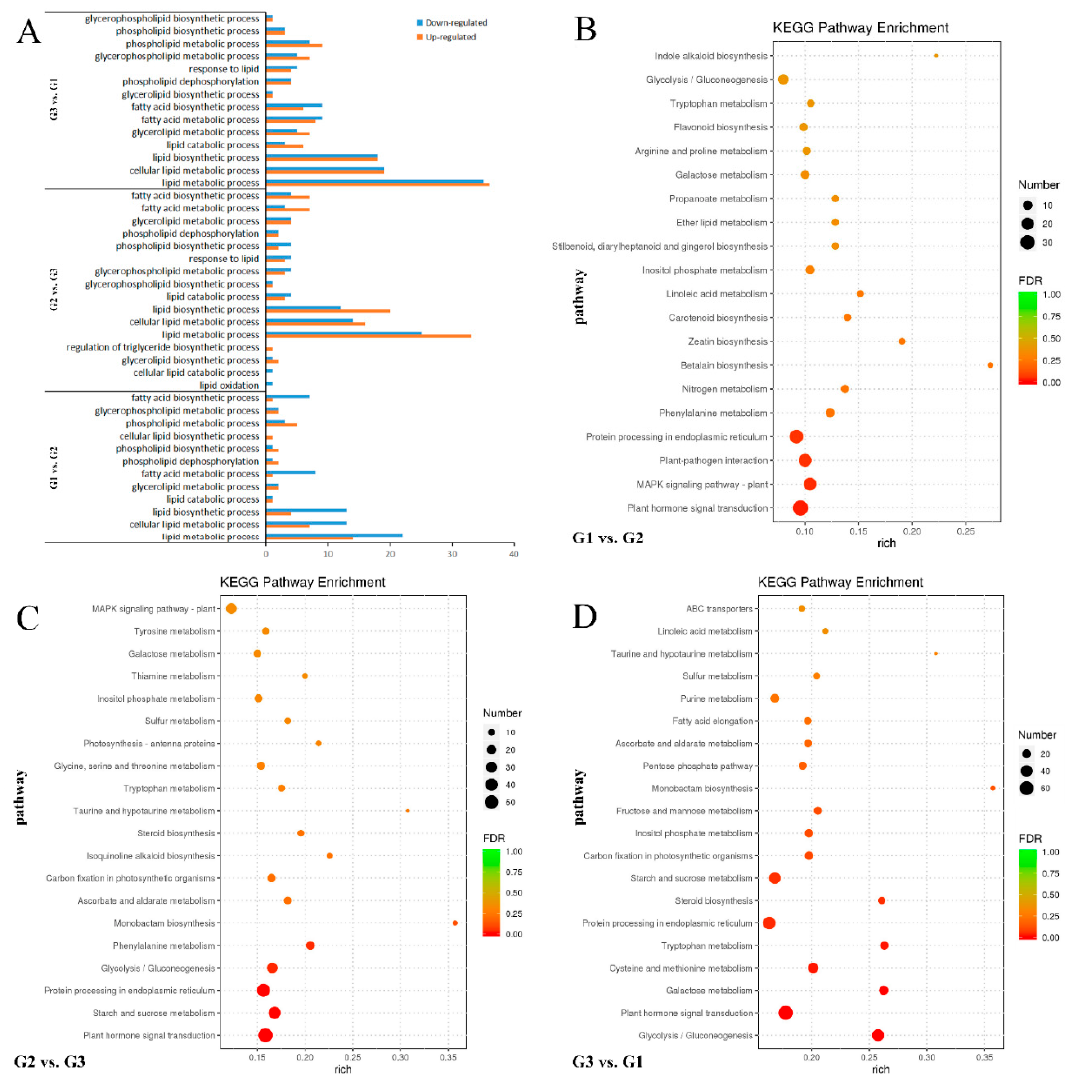
Figure 2. Enrichment analysis of all DEGs. ( A ) DEGs related to FA synthesis screened. ( B – D ) The top 20 KEGG pathways with the most significant enrichment of G1 vs. G2, G2 vs. G3, G3 vs. G1, accordingly.